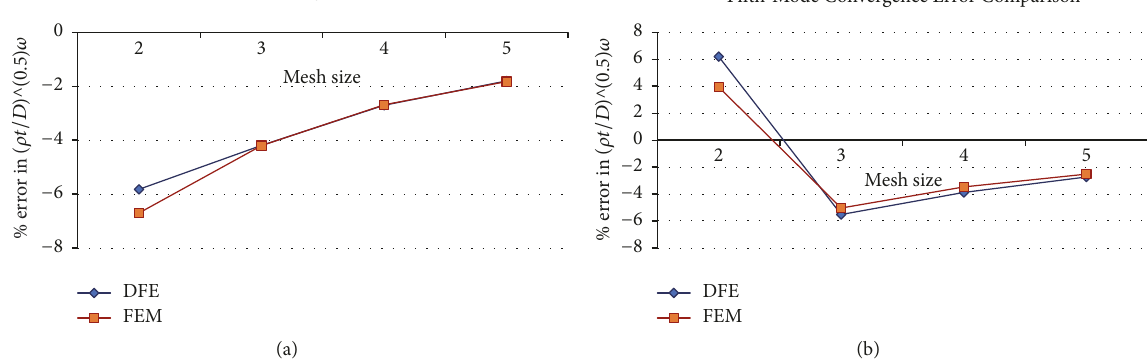
Figure 4: Comparison of convergence of 𝜔√𝜌𝑡/𝐷 values to analytical solution provided by [20] between FEM and DFE models for second mode (a) and fifth mode (b) of vibration of a plate under SS-SS-SS-F boundary condition.